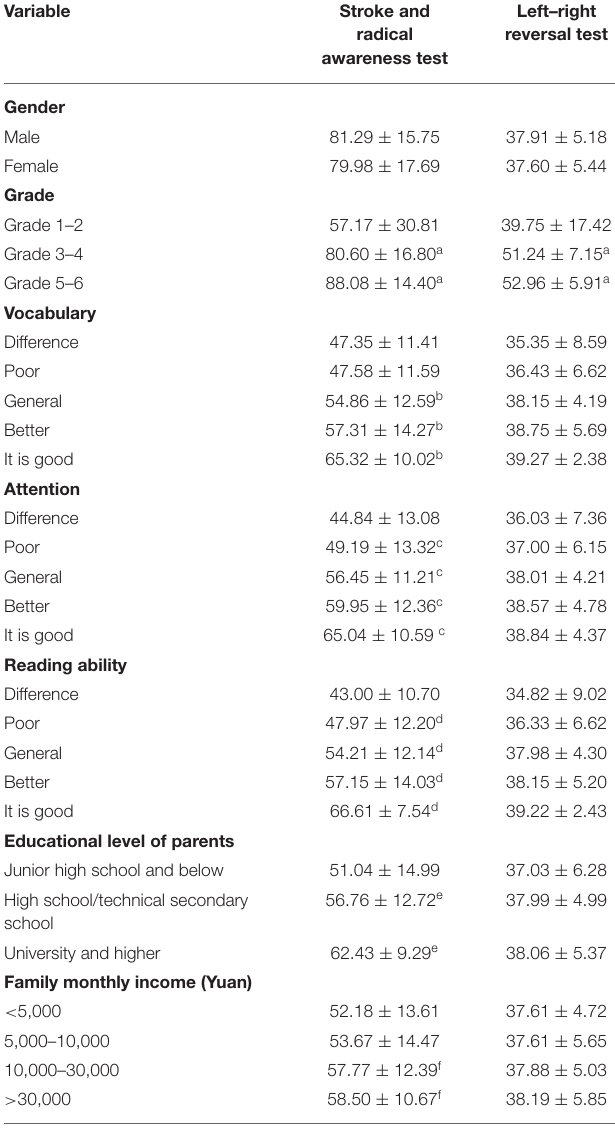
TABLE 7 | Comparison of average scores in various dimensions between children with different characteristics and their parents ( X ± s).